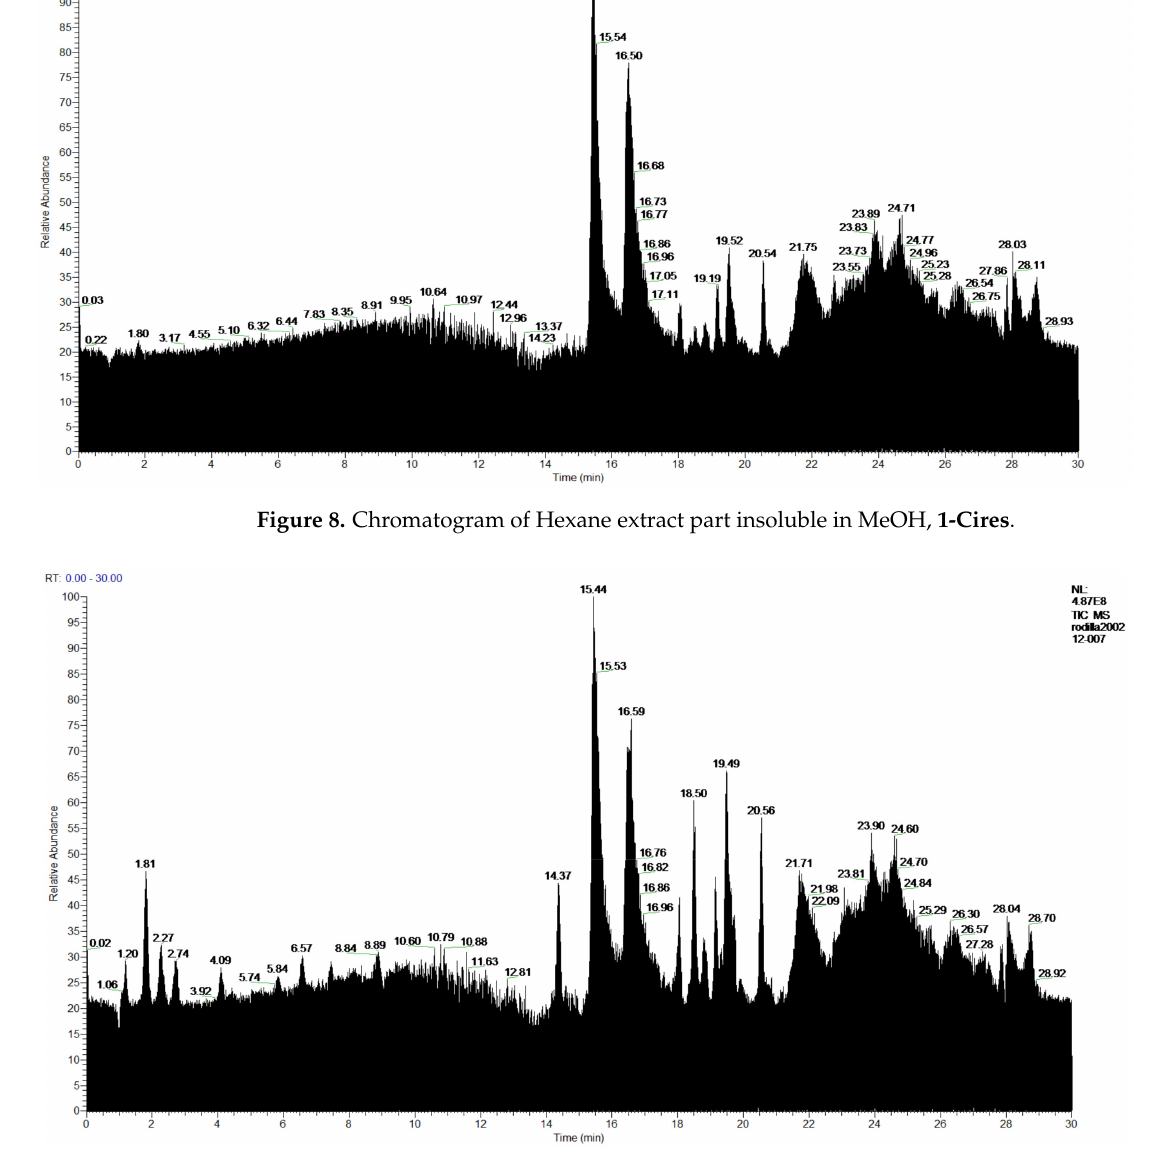
Figure 9. Chromatogram of Hexane extract part insoluble in MeOH, 2-Cires